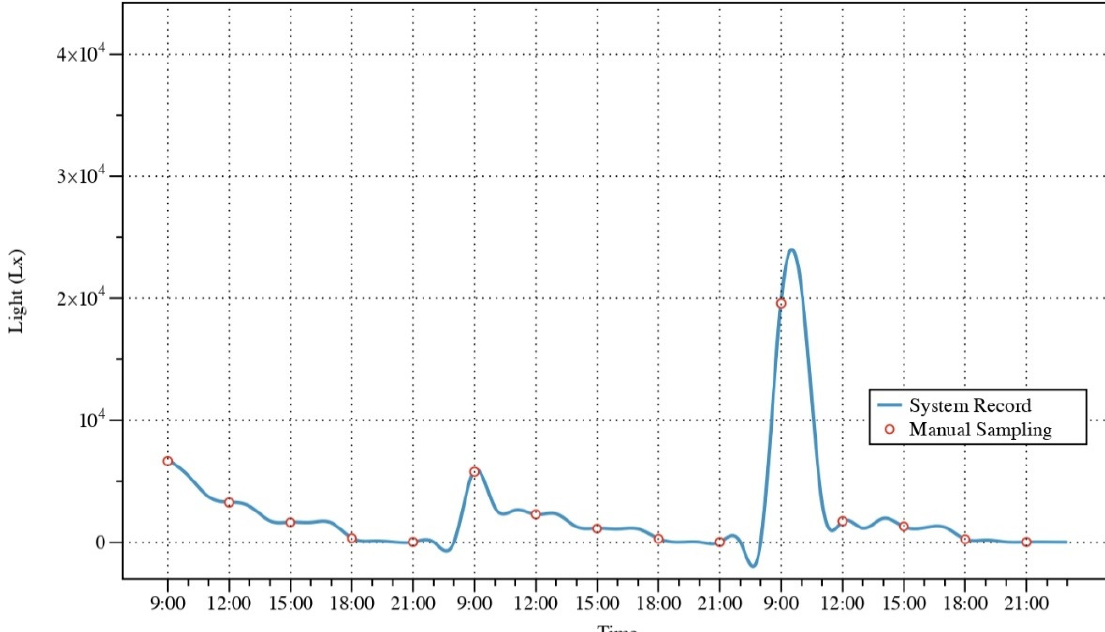
Figure 15. System record value and manual sampling of light intensity.